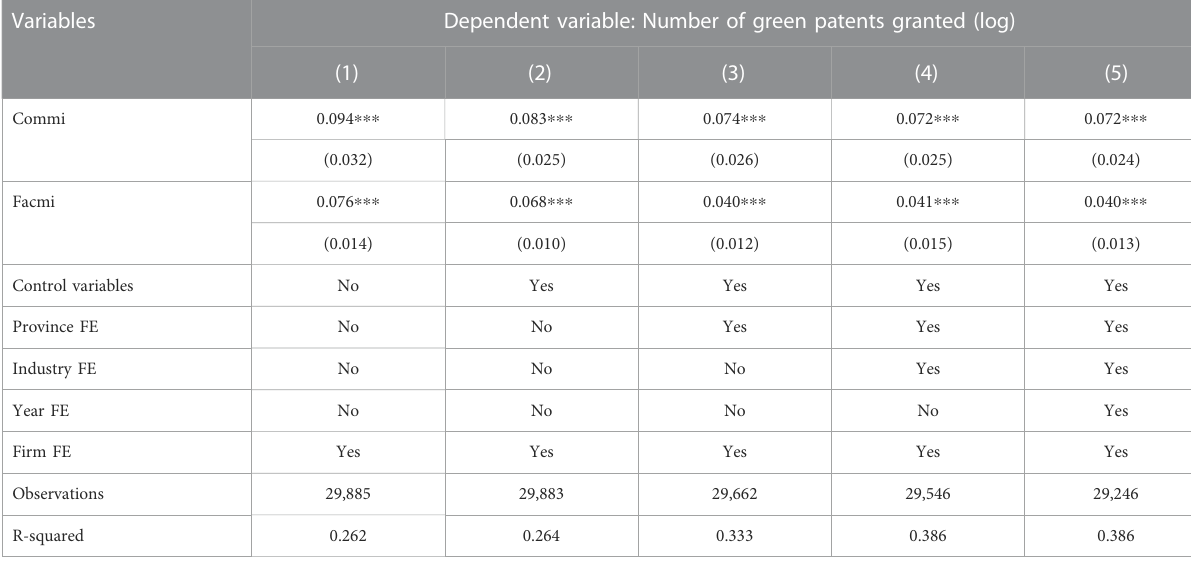
TABLE 2 OLS estimates of the impact of market integration on green technology innovation.